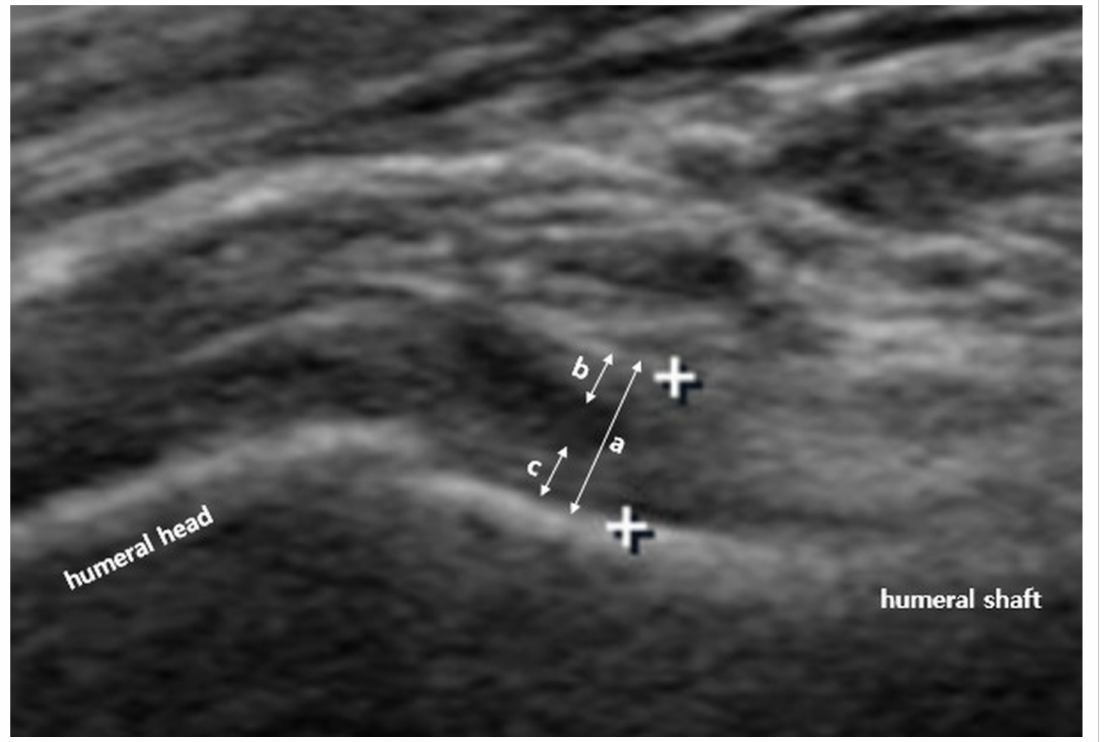
Figure 2. Ultrasonographic measurement of inferior joint capsule (IJC) thickness. IJC thickness was defined as the distance from the cortex of the humerus to the outer margin of the capsule at the widest portion of the capsule. IJC thickness ( a ) includes both the glenoid side ( b ) and humeral side ( c